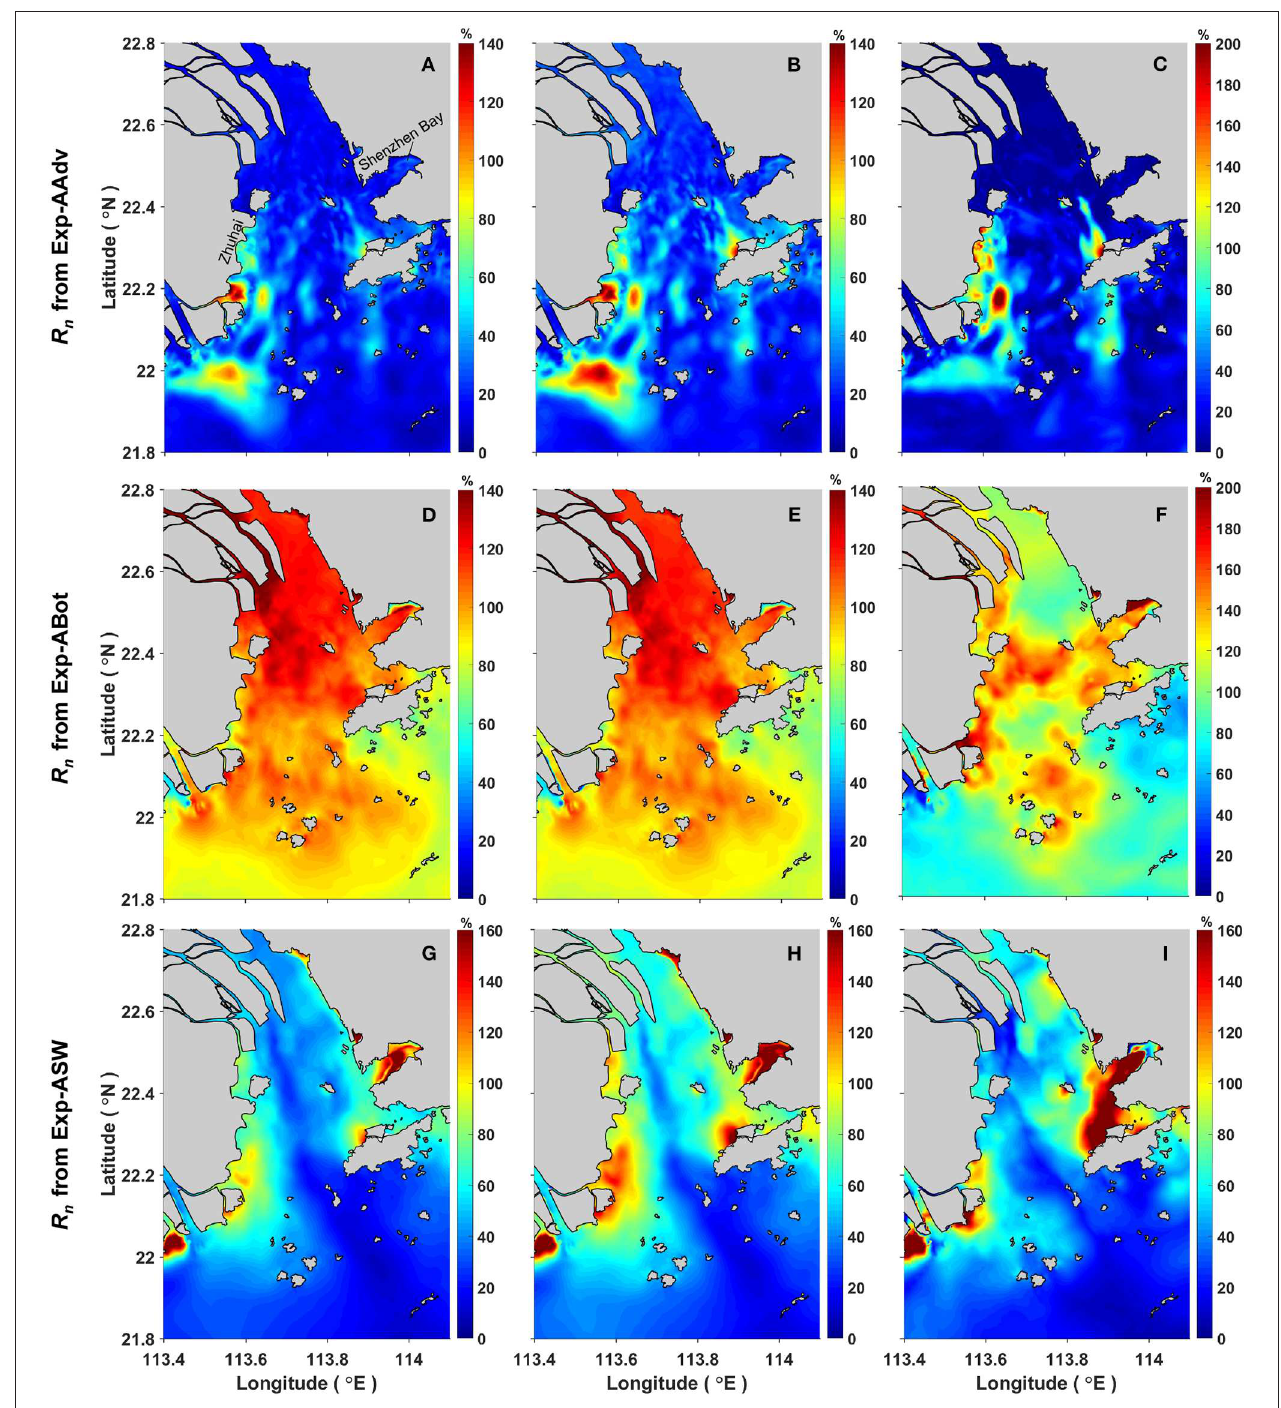
FIGURE 10 | Similar as Figure 9 but for R n calculated by the “addition” numerical approach as described in section 5.2. (A–C) Show R n values calculated by using RMS ( ζ TSI ), I r , and MAX ( ζ TSI ), respectively, from the reduced experiment Exp-AAdv; (D–F) show the R n values calculated by using RMS ( ζ TSI ), I r , and MAX ( ζ TSI ), respectively, from the reduced experiment Exp-ABot; (G–I) show the R n values calculated by using RMS ( ζ TSI ), I r , and MAX ( ζ TSI ), respectively, from the reduced experiment